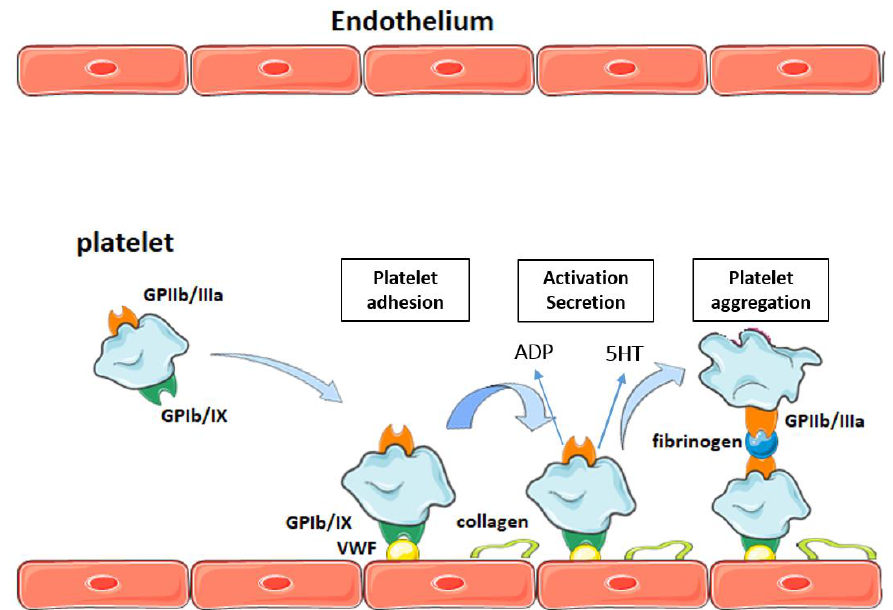
Figure 1. Platelet function in the process of primary hemostasis. ADP, adenosine diphosphate; VWF, von Willebrand factor; GP, glycoprotein; 5HT: serotonin.